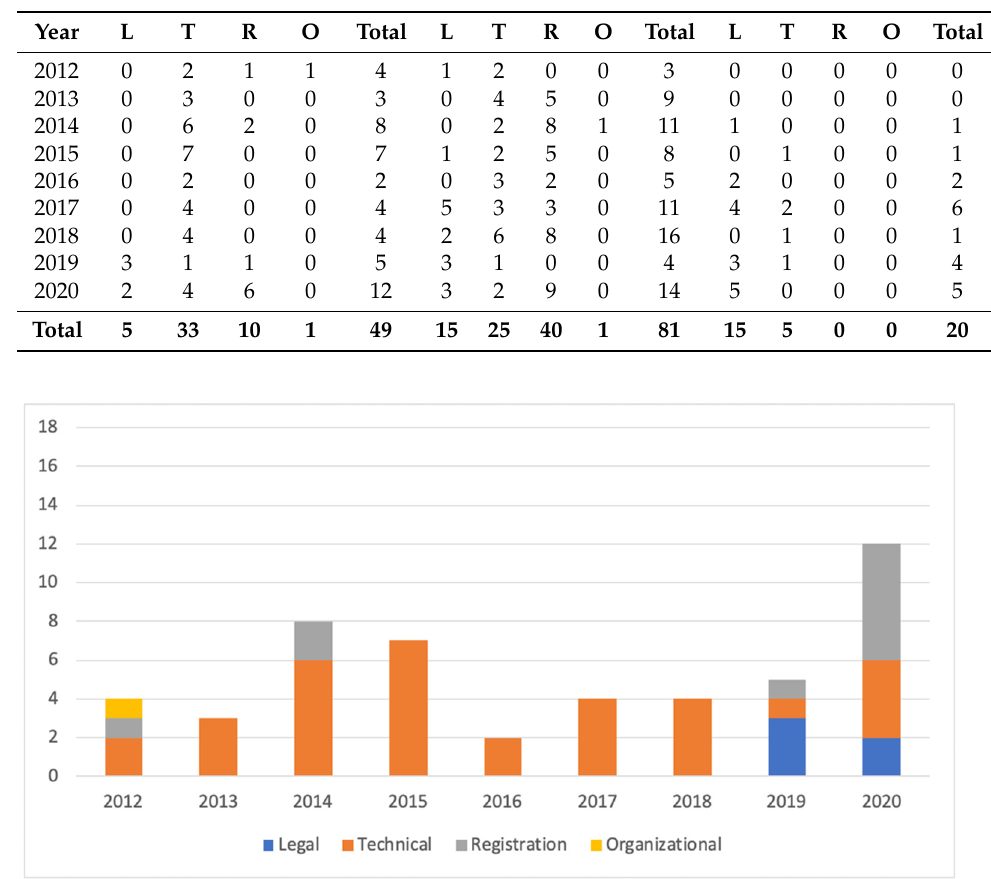
Figure 8. Distribution of non-LADM related standardization topics. 7. Analysis The results from the literature survey are analyzed below in relation to the research areas, with focus on the legal category. In addition to that, identified trends in 3D legal research during the studied period are examined. Since the topic of the paper is legal re- search, the analysis focuses on legal issues and trends and identified topics within that specific area. 7.1. Research Areas It can be noticed that the number of publications in recent years have increased sub- stantially, with more than three times the amount but in less years. The number of publi- cations belonging to the legal category has decreased in relation to the other categories, also as a secondary theme, which might be explained by the fact that in many countries, the legal system has developed in recent years and now already is in place. Registration